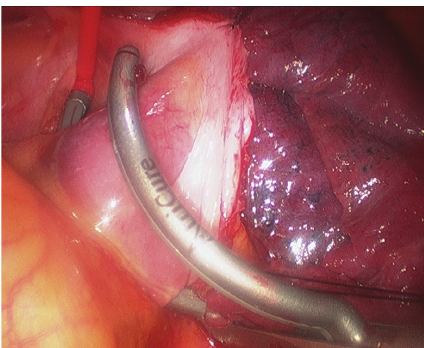
Figure 2: Pulmonary vein ablation by bipolar radiofrequency through a thoracoscopic approach. The ablation line can be seen in the left atrium at the antrum of the pulmonary veins.